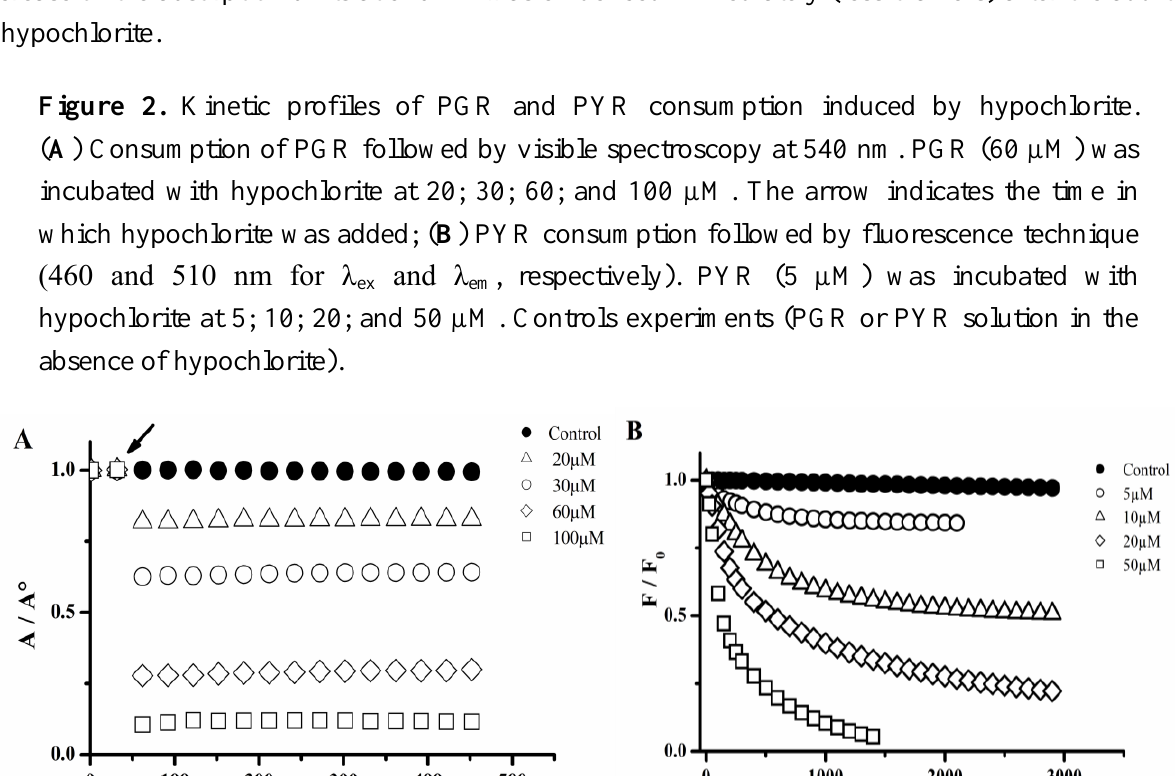
Figure 2. Kinetic profiles of PGR and PYR consumption induced by hypochlorite. ( A ) Consumption of PGR followed by visible spectroscopy at 540 nm. PGR (60 µM)